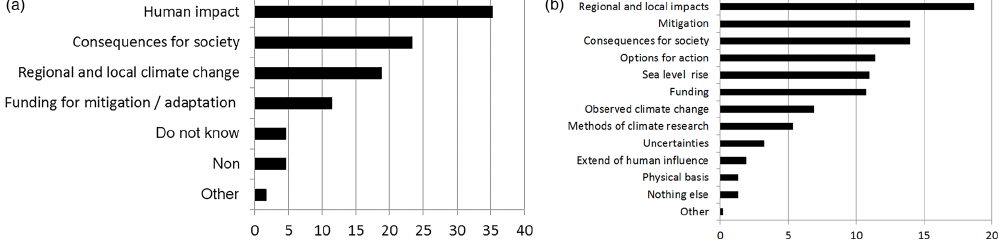
Figure 3. (a) Which of the following climate change information are most relevant for you? (Survey general public, percentage of N = 630); (b) on which research field would you like to have additional information? (Survey municipality mayors, percentage of N = 165).